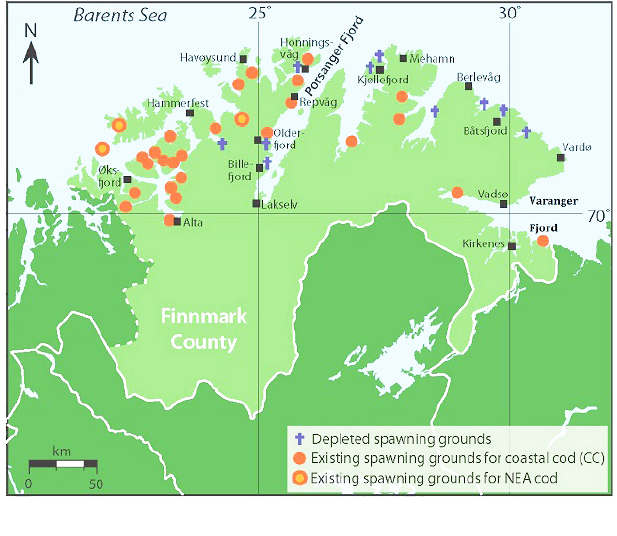
Fig. 1 . Porsá η gu and Várjat vuotna are two of the major fjord areas in Finnmark County. The map shows spawning grounds for Northeast Arctic cod ( Gadus morhua ), coastal cod, and depleted spawning grounds for coastal cod, based on interviews with 70 fishers in 1996, by social scientist Anita Maurstad and marine biologist Jan H. Sundet (Maurstad and Sundet